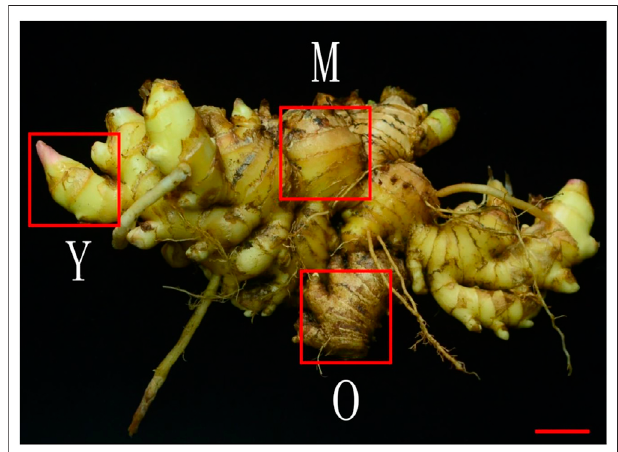
FIGURE8| Theginger Z.of fi cinale Roscoe,ChinesecultivarHunan Xiao Jiang. Y (young), M (mature), and O (old) tissues of the rhizome used for transcriptome and metabolome analysis. The red bar indicates 2